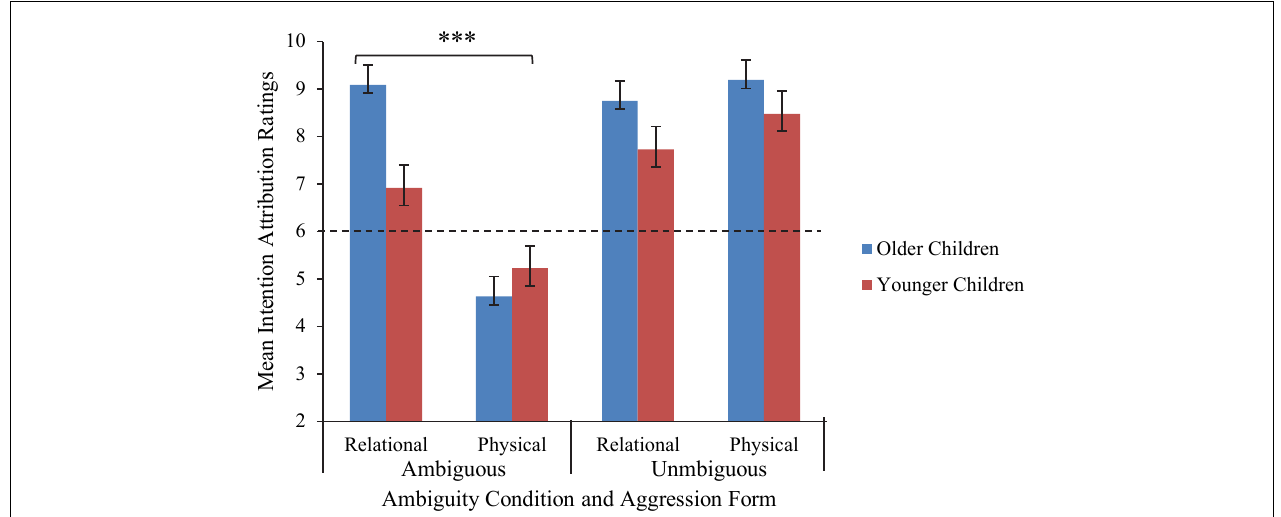
FIGURE 5 | Mean intention attribution ratings by aggression form, ambiguity condition, and age group. Error bars represent SEs. Note that intention attributions were coded as follows: 1, not at all; 2, a little; 3, sort of; 4, a lot; and 5, a whole lot. Ratings were summed across transgressor gender, resulting in a range of 2–10. *** Indicates a significant age × aggression form interaction ( p < 0.001).